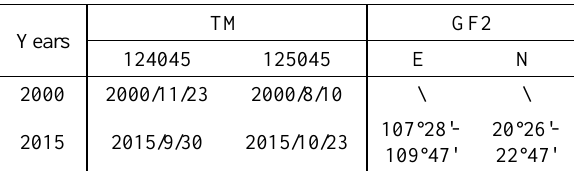
Table 1. Satellite remote sensing imaging